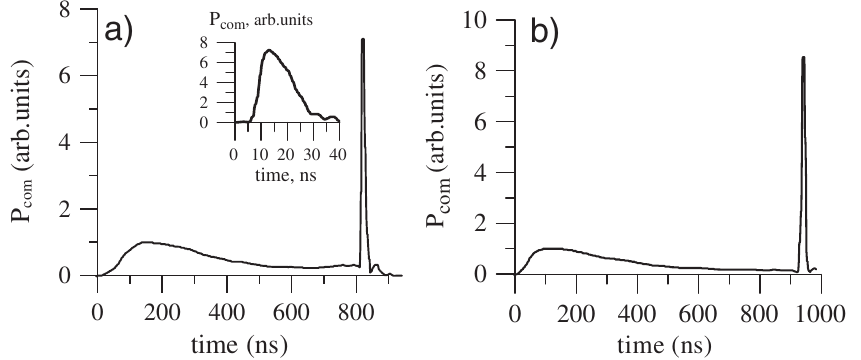
FIG. 11. Characteristic oscillograms of the compressed pulse in the output of the quasioptical active pulse compressor.